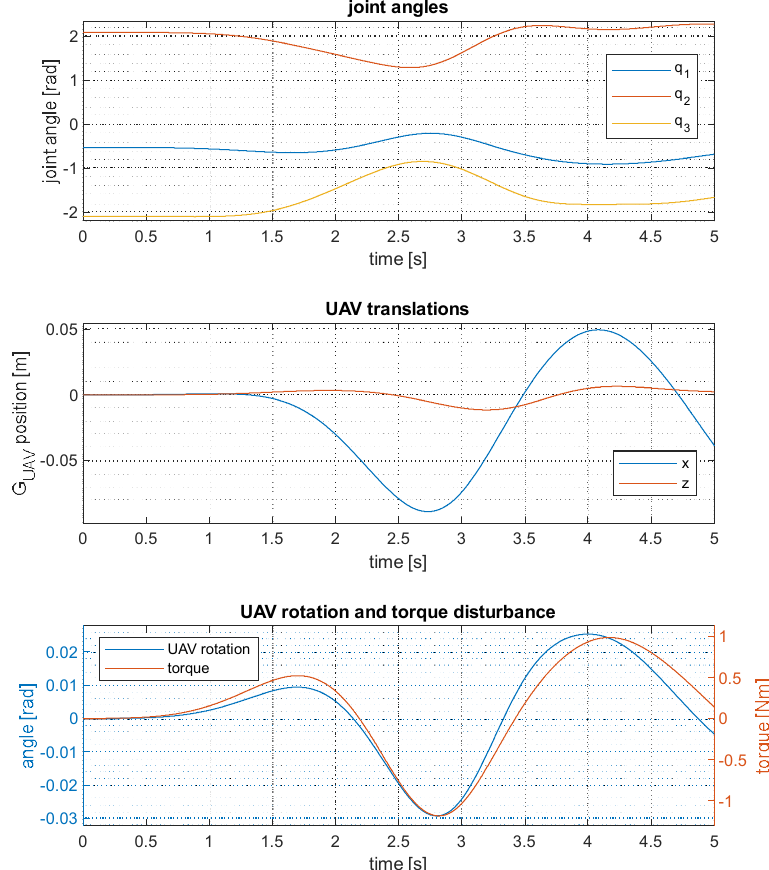
Figure 15. Manipulator ( top ) and UAV motions and torque disturbance ( middle and bottom ) for the 3-DOF UAM using the generalized Jacobian with external forces performing a circular trajectory task.